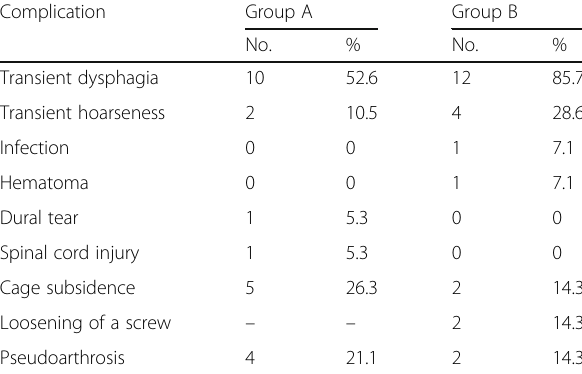
Table 4 Incidence of